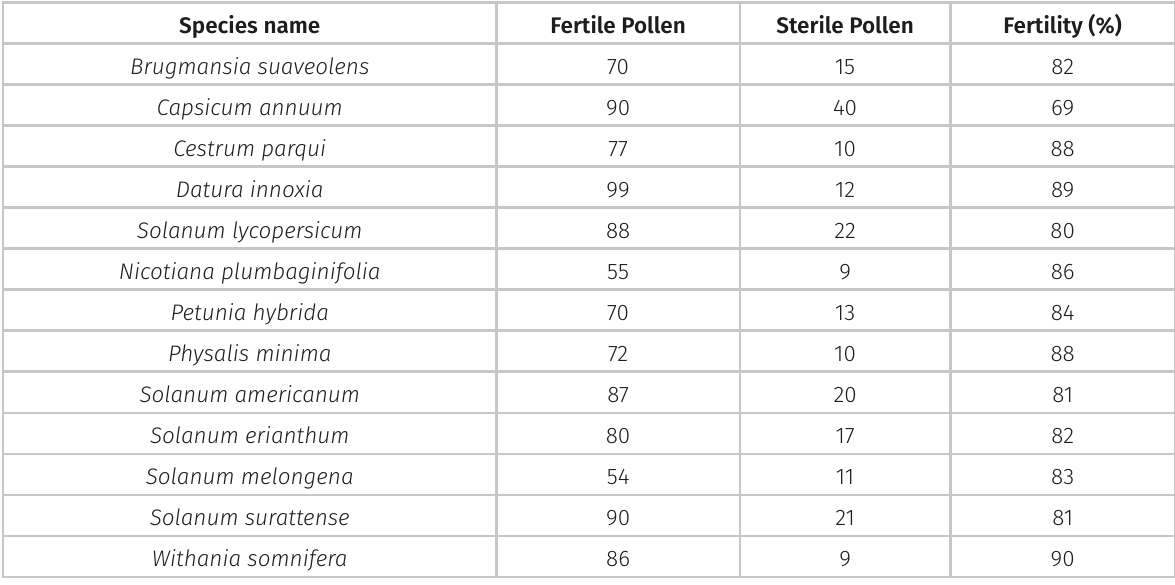
Table IV. Pollen fertility percentages for Solanaceous species from arid zone of Pakistan.